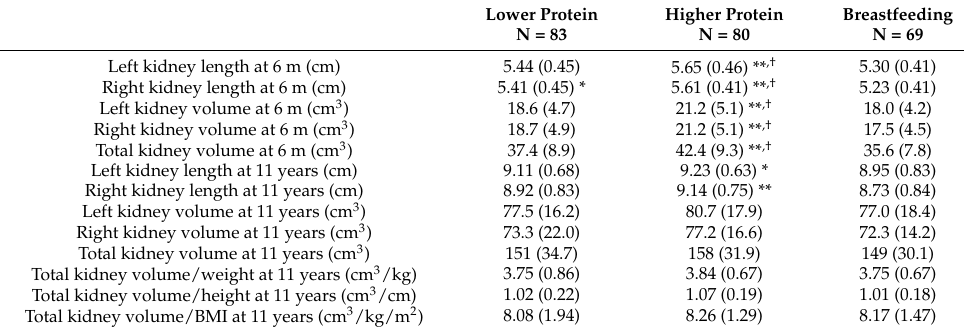
Table 2. Kidney measurements at 6 months and 11 years of age.